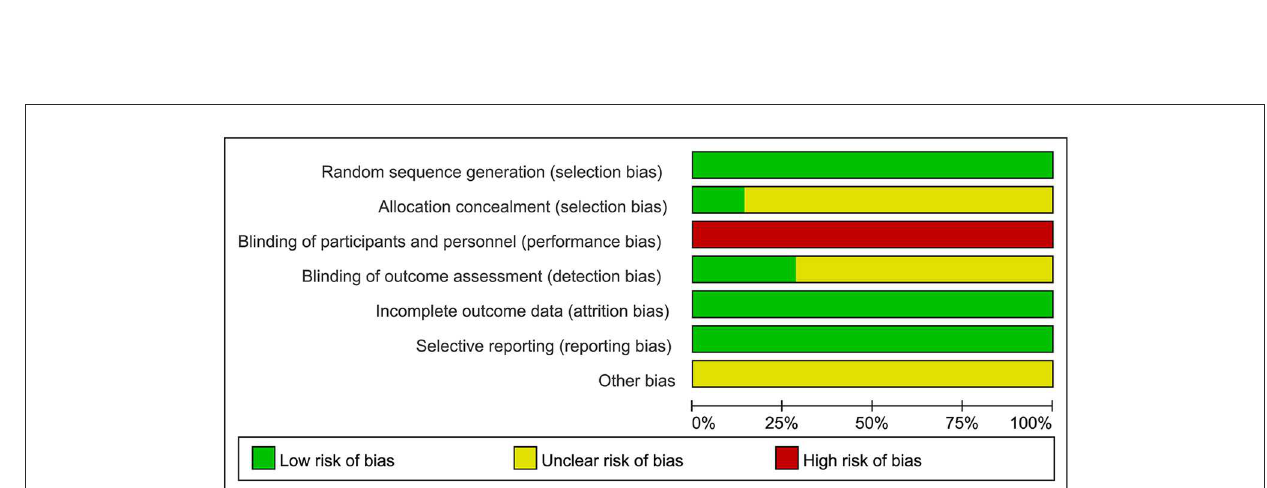
FIGURE2 Bias risk diagram: judgment of risk of bias expressed as a percentage of all included